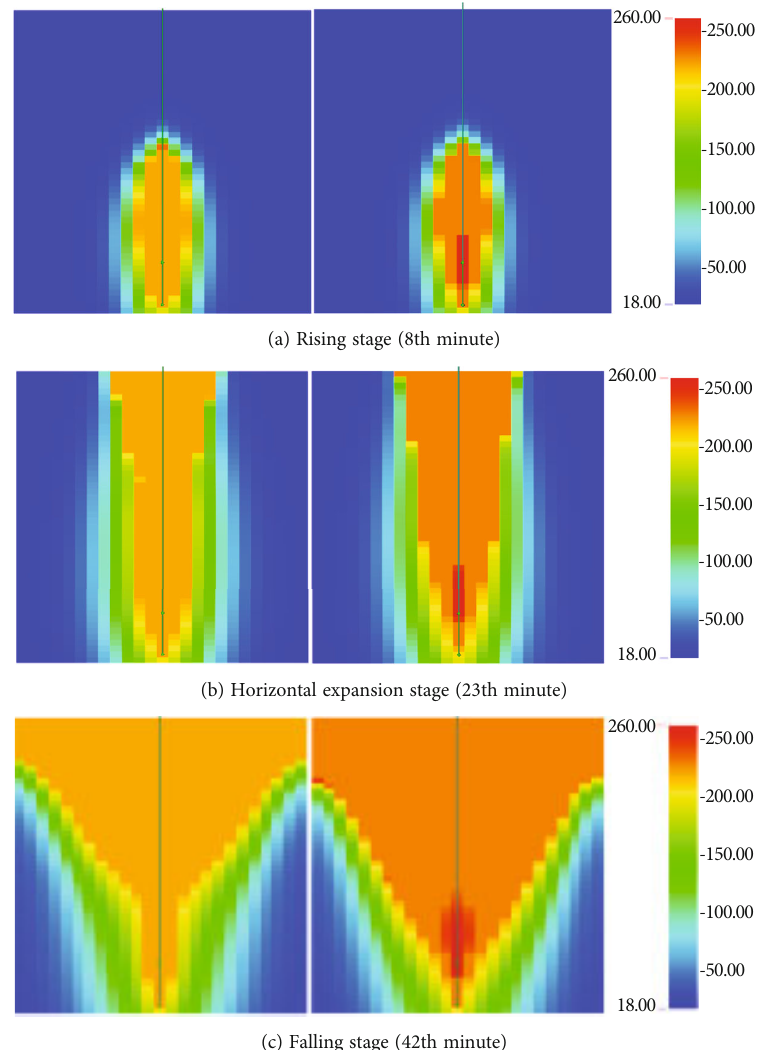
Figure 22: Temperature distribution in di ff erent periods of 220 ° C saturated SAGD (left) and 320 ° C superheated SAGD (right).